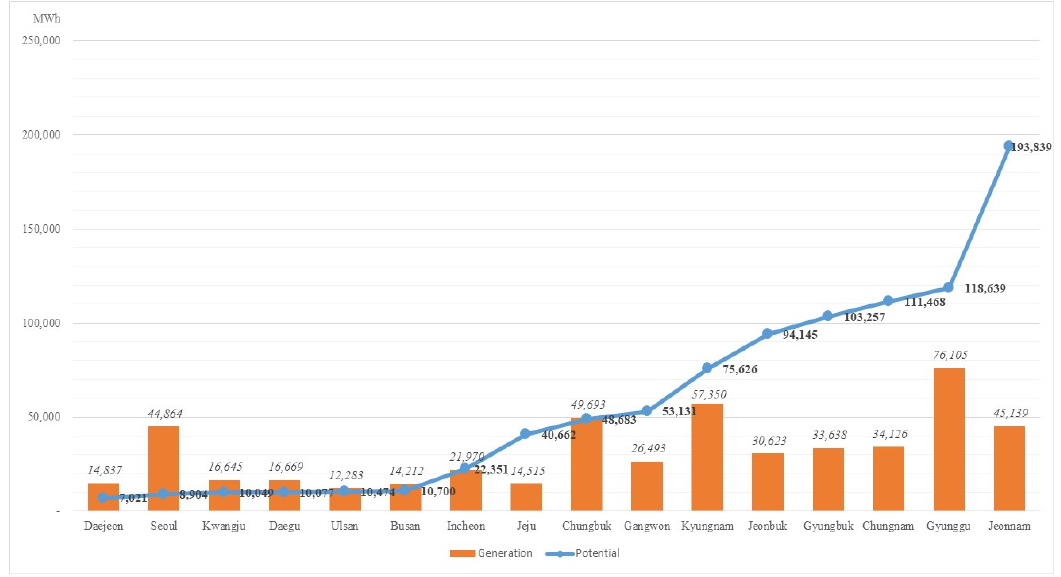
Figure 1. Solar resource potential compared to solar power generation in 16 regions.